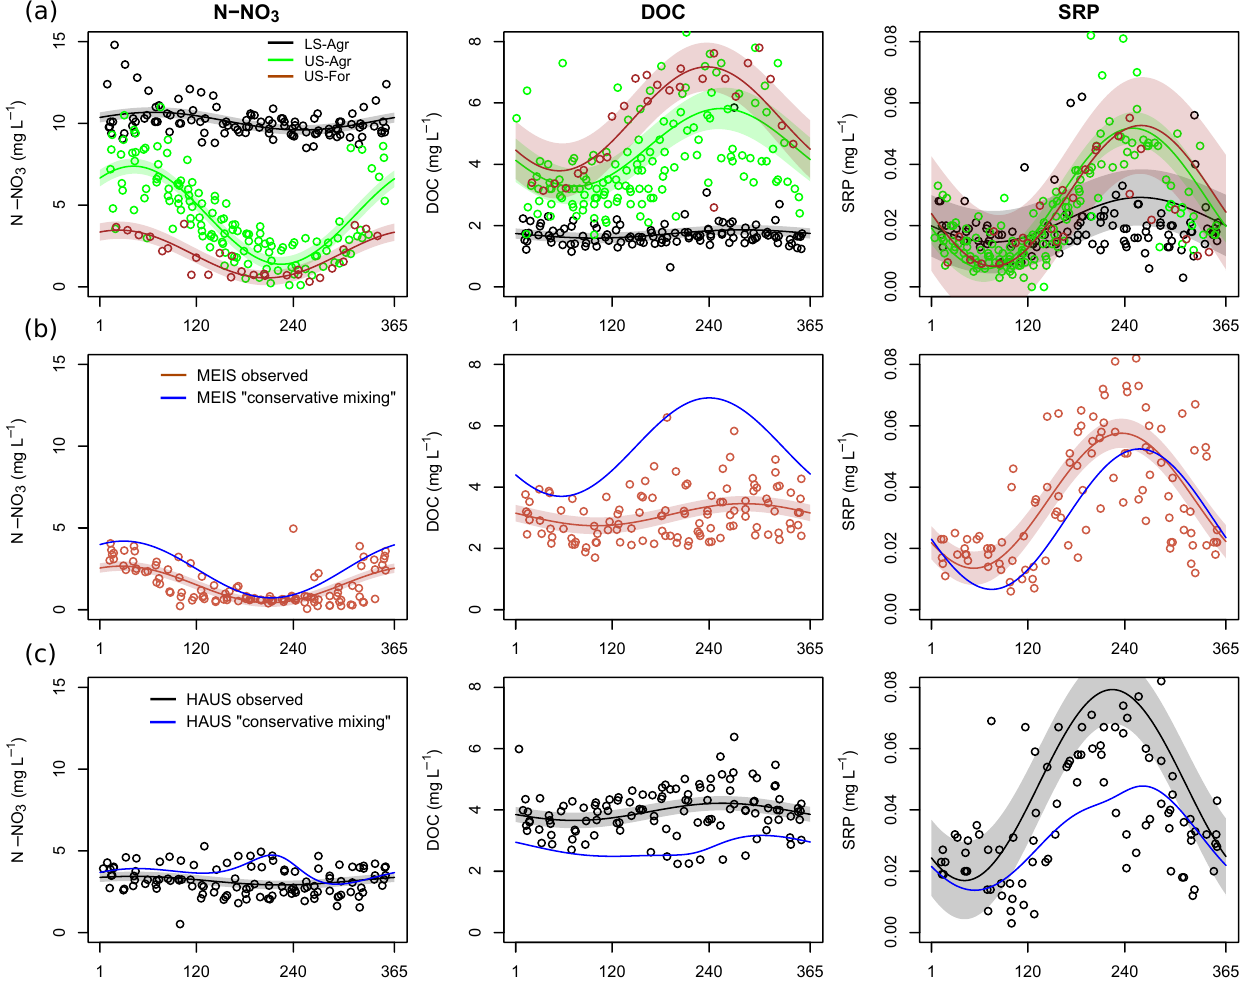
Figure 3. Intra-annual variability of nitrate (N − NO 3 ), dissolved organic carbon (DOC) and soluble reactive phosphorus (SRP) in headwater catchments (a) and in the downstream catchments Meisdorf (b) and Hausneindorf (c) . Circles represent observation data, lines represent cosine fitting and shaded areas represent 95% confidence intervals. “Conservative mixing” represents the theoretical signal that would have been obtained through mixing of headwater signals without any in-stream or point-source